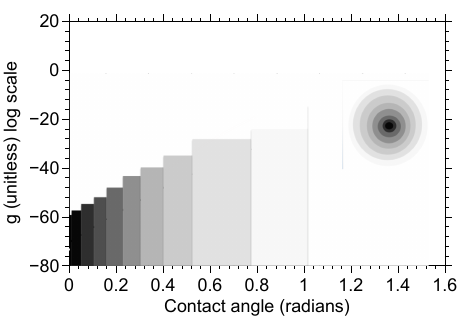
Figure 2. Upper right inset displays the distribution of ice nucle- ation activity (contact angle, θ) for a representative spectrum of a particle’s ice nucleating activity. The less active (white) surface sites have more surface coverage while the more active (black) surface sites have less coverage. The probability distribution function for the g distribution ( µ = 1 . 65 and σ = 0 . 135, retrieved in Sect. 3.1) ascent in log space is plotted with numerical bins. The darker colors are used to highlight the stronger ice nucleating activity at smaller contact angles ( θ)